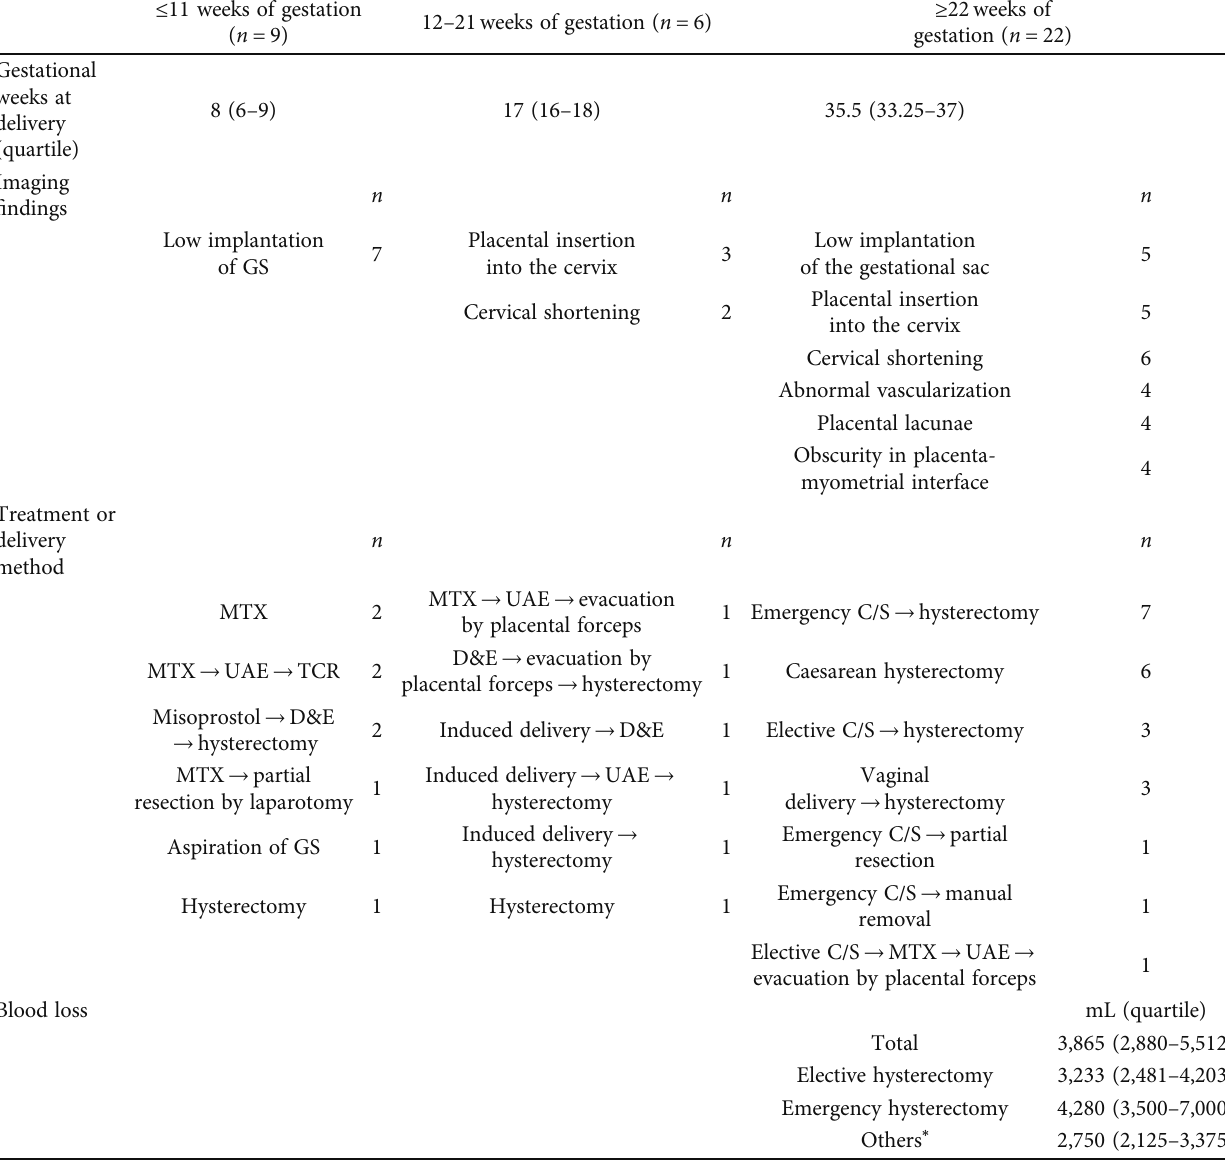
Table 1: Clinical characteristics of cervico-isthmic pregnancy according to gestational age at